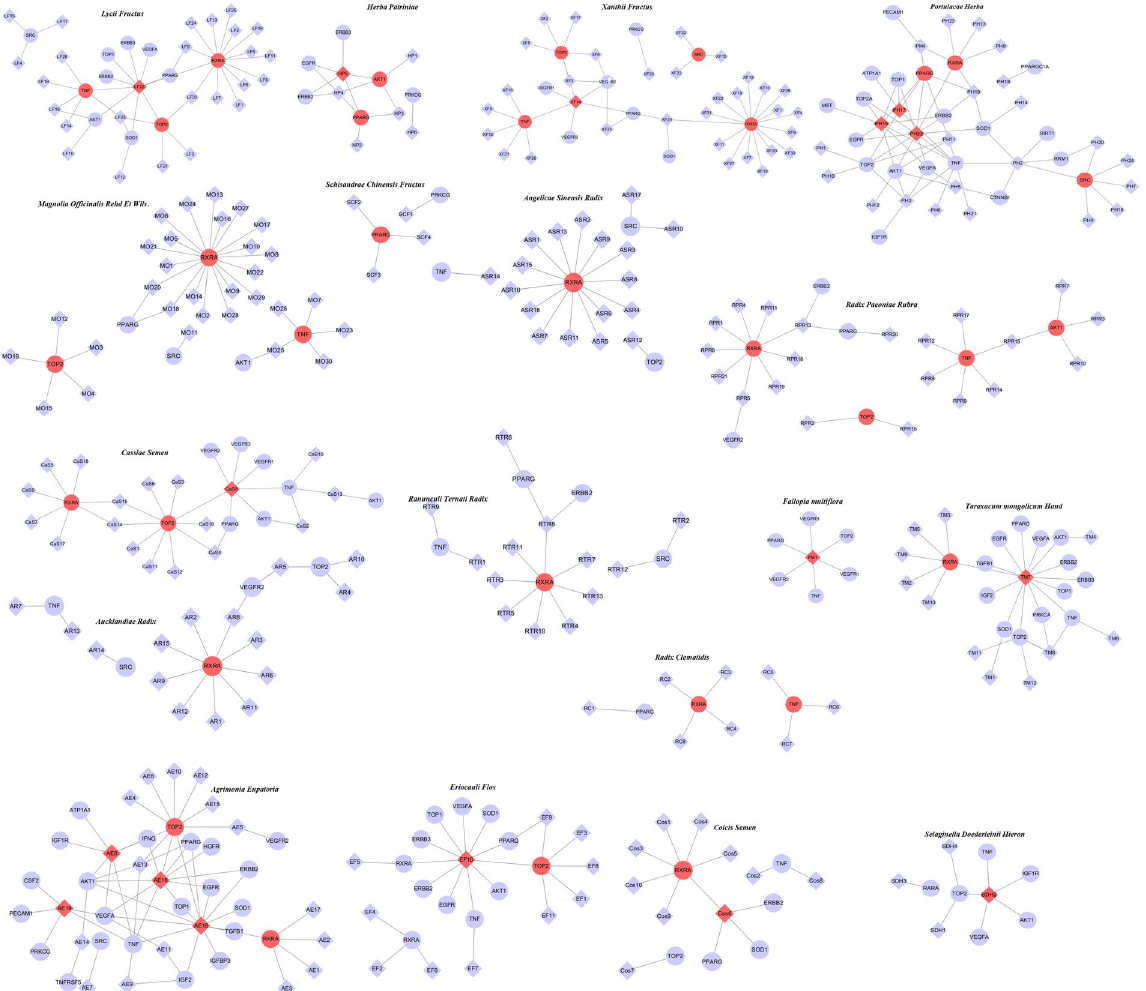
Figure 5. The ingredient-target networks. The diamond nodes represent ingredients, the circular nodes represent targets, and the nodes with red color are the major ingredients and targets involved in CRC treatment. LF , Lycii Fructus ; MO , Magnolia officinalis Rehd Et Wils; RC , Radix Clematidis ; AR , Aucklandiae Radix ; ASR , Angelicae sinensis Radix ; XF , Xanthii Fructus ; EF , Eriocauli Flos ; CaS , Cassiae Semen ; FM , Fallopia multiflora ; SDH , Selaginella doederleinii Hieron ; HP , Herba Patriniae ; PH , Portulacae Herba ; CoS , Coicis Semen ; TM , Taraxacum mongolicum Hand ; AE , Agrimonia eupatoria ; RTR , Ranunculi ternati Radix ; SCF , Schisandrae chinensis Fructus ; RPR , Radix Paeoniae rubra